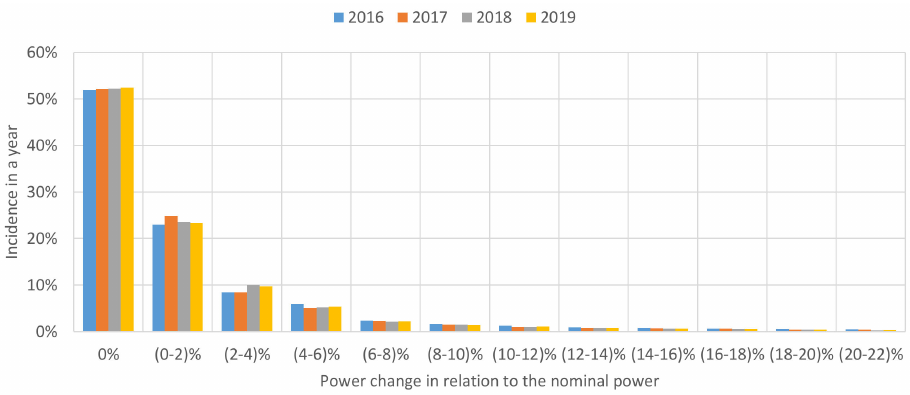
Figure 13. Percentage incidence of relative power change for the photovoltaic power